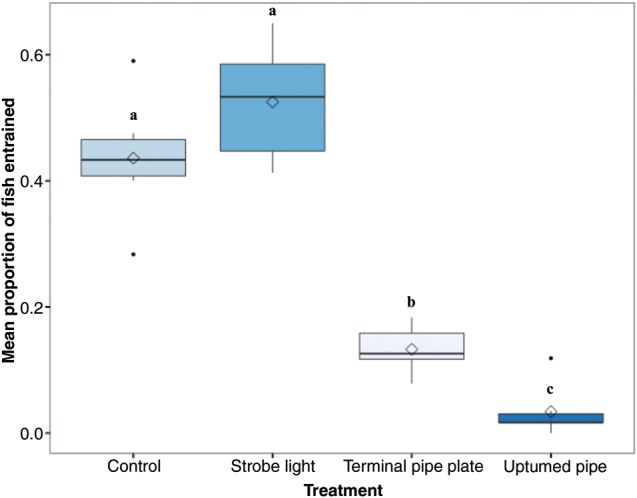
The proportion of fish entrained into the diversion pipe for each treatment. Boxplots of the proportion of fish that were diverted through the diversion pipe in each trial out of the total number of fish tested within the flume. Different letters represent statistically significant differences among treatments. Key: black line, median; box, interquartile range; whiskers, 1.5 × interquartile range; filled circles, outliers; and open diamond, mean. Mean proportions of fish diverted for each treatment (±SEM) are reported in the text. n = 6 trials for each treatment; 60 (±3) fish per trial.